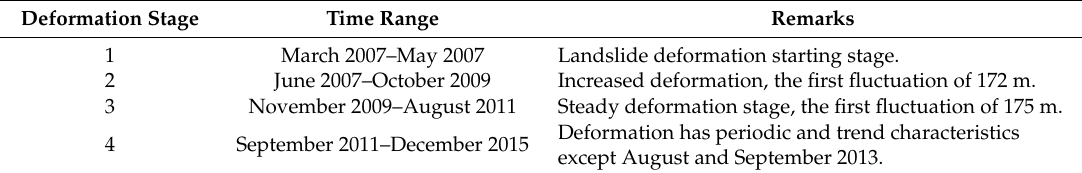
Figure 8. Rainfall, reservoir water level, and cumulative displacement monitoring data from the landslide area. Table 1. Deformation stages of the Shengjibao